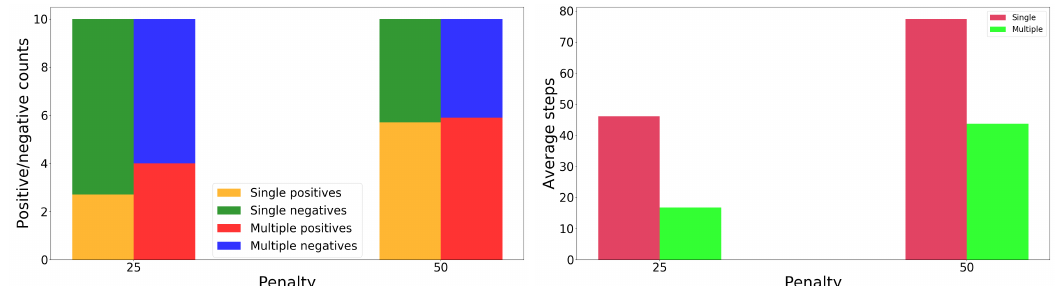
Figure 16. Real experiment, comparison between the single- and multiple-position observations: Count of positive/negative classifications ( left ) and total number of steps needed to sort 10 light bulbs ( right